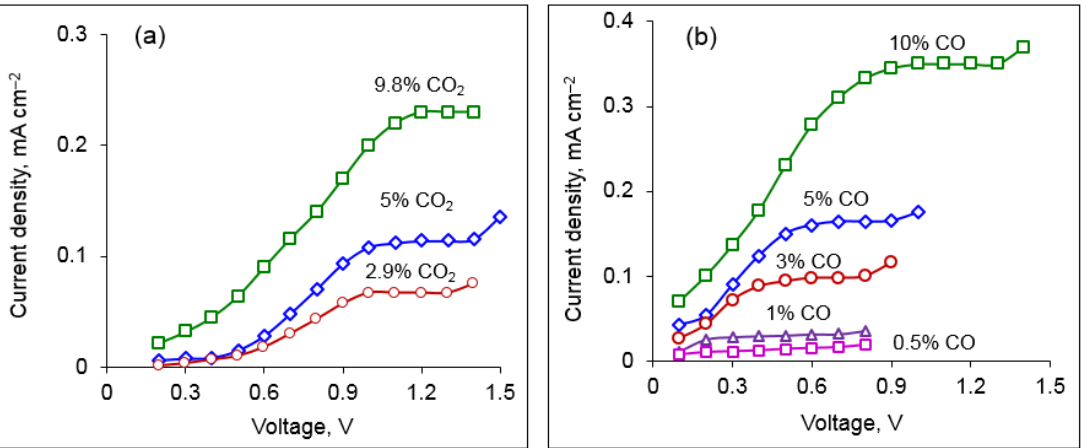
Figure 5. Current–voltage dependences of ( a ) cell 1 in N 2 + CO 2 gaseous mixtures, ( b ) cell 2 in N 2 + CO gaseous mixtures, at 700 °C. Error bars are smaller than the symbol size.